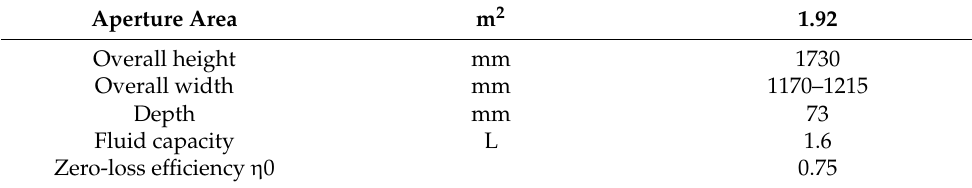
Table 1. Technical specification of the flat plate